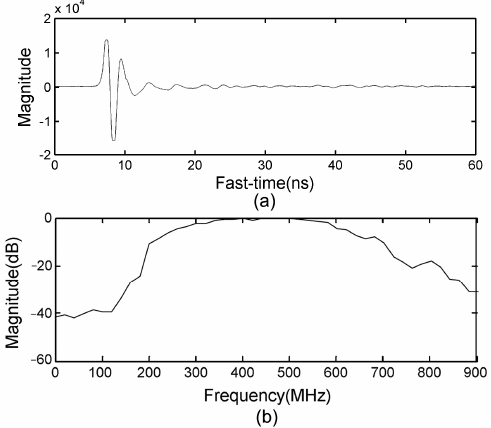
Figure 2. ( a ) One received waveform; ( b ) and the spectrum of the received waveform.